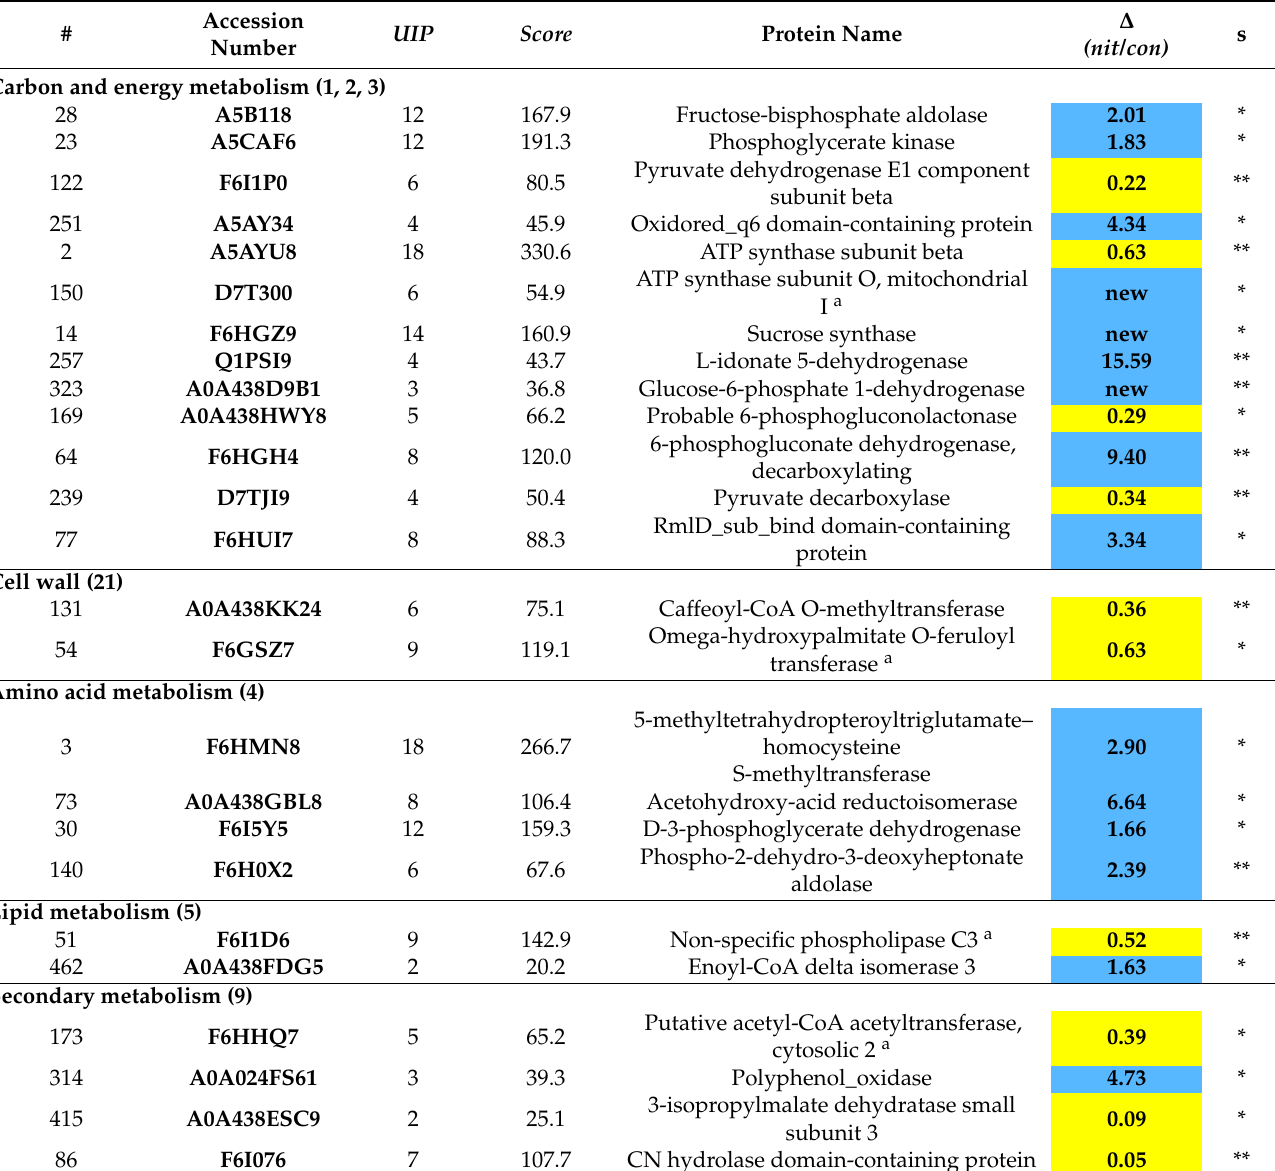
Table 1. Proteins differentially accumulated in response to 10 mM NO 3 − for 30 h in roots of M4. Proteins are grouped according to functional classification (Figure 3). Subtitles report functional categories and their bin codes. # : identification number (group). UIP : number of unique identified peptides. Score : MS/MS search score. ∆ ( nit/con) : fold